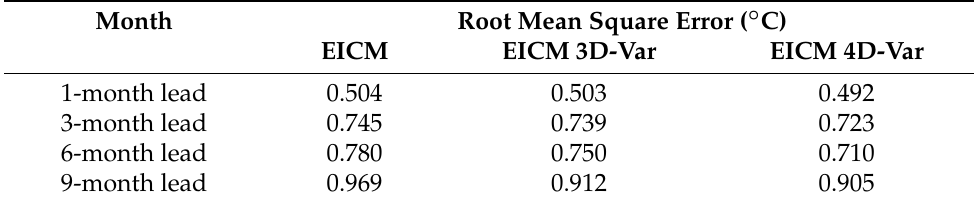
Table 2. Statistics of the EICM and EICMDA in comparison with in-situ measurements for Lead time in months.